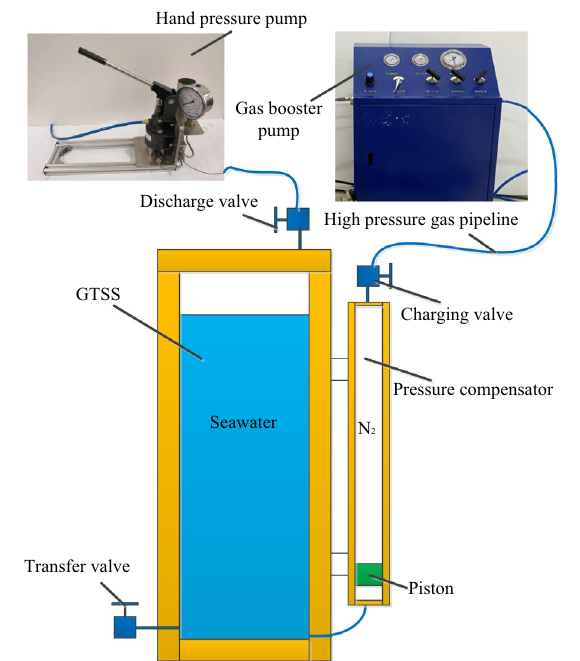
Figure 8 Schematic diagram of internal pressure test of